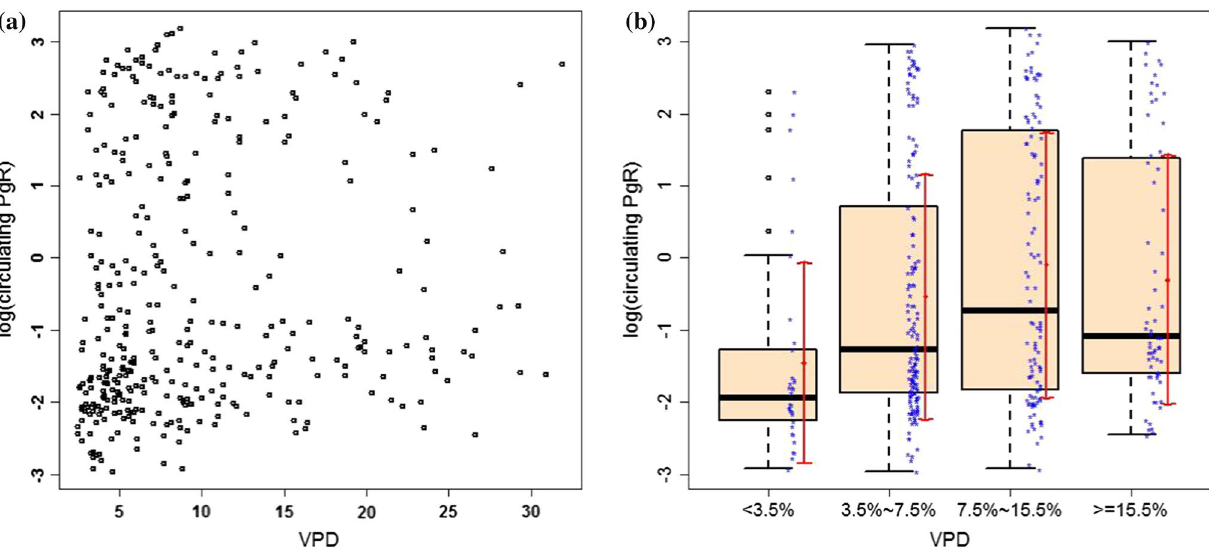
Fig. 2 a Scatterplot of cPgR (in log scale) with VPD (Spearman cor = 0.21, p = 5.35E-05) b Boxplot of PgR (in log scale) by VPD category (blue points represent each data point, red dot and arrow indicate mean and SD, black horizontal line indicates median). The overall Kruskal–Wal- lis test comparing circulating PgR by the 4 VPD categories indicated significant difference among the 4 categories (P = 9.58E-05) and post- hoc pairwise Wilcoxon rank sum test with Benjamini–Hochberg adjustment on p values indicated significant difference between the lowest “ < 3.5%” category with each of the three higher categories in sequential order (adjusted P = 0.00074, 0.00011, and 0.00011, respectively) but not